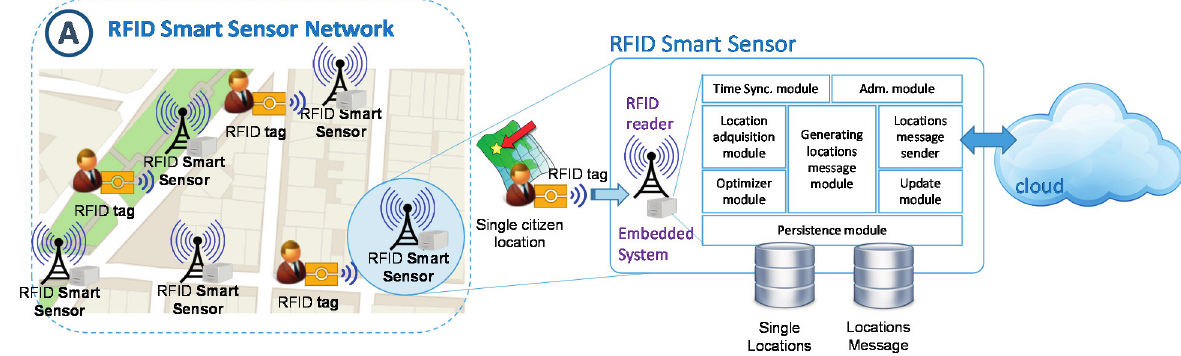
Figure 7. RFID smart sensor